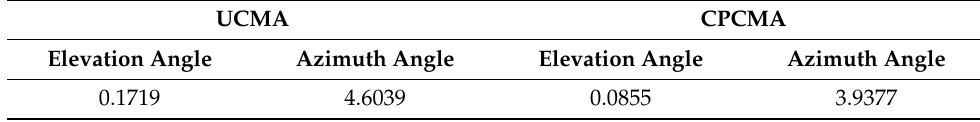
Table 17. Root-mean-square error (RMSE) in outer race defect located by both arrays at 725 rpm.